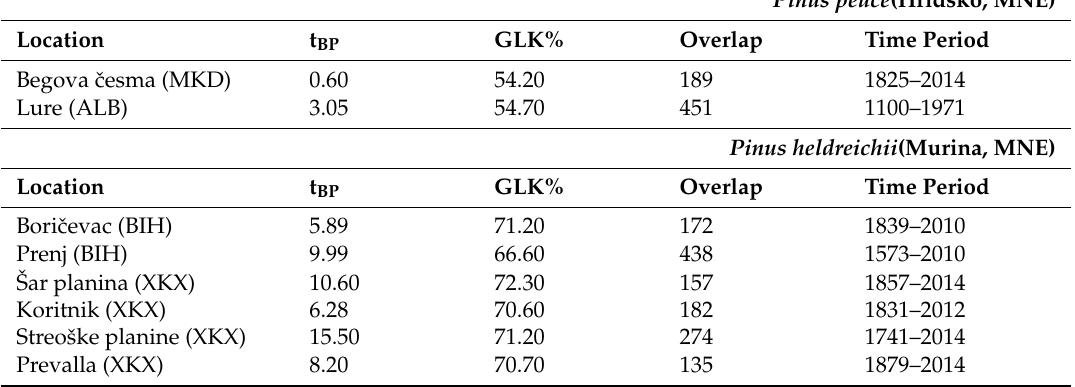
Pinus peuce (Hridsko,